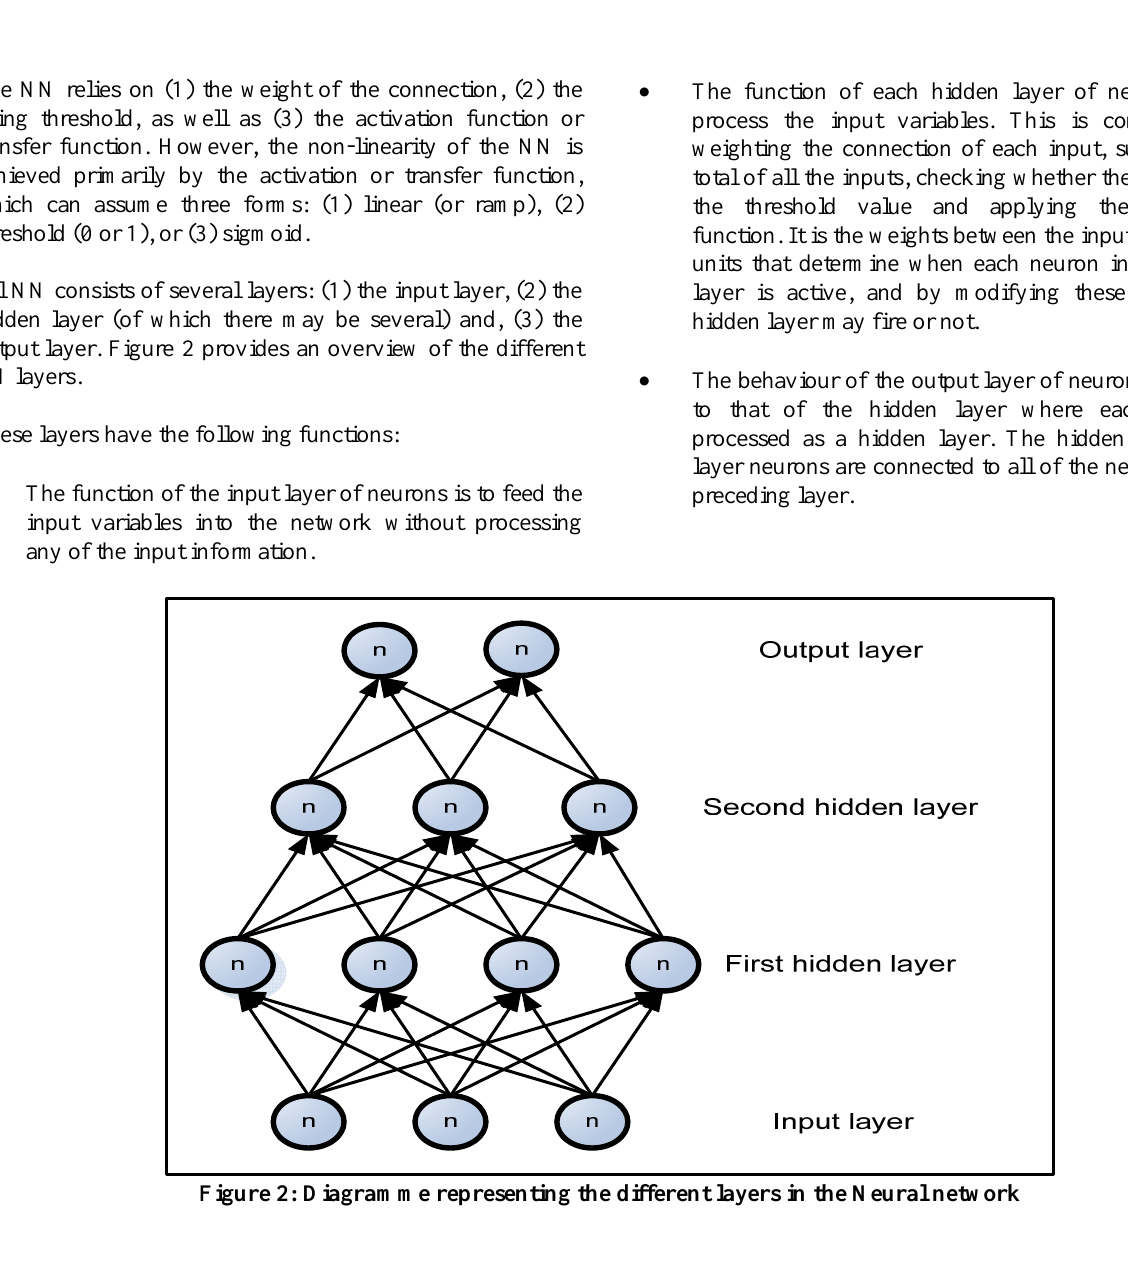
Figure 1: Diagramme representing an artificial neuron (J. Zirilli: 1997)